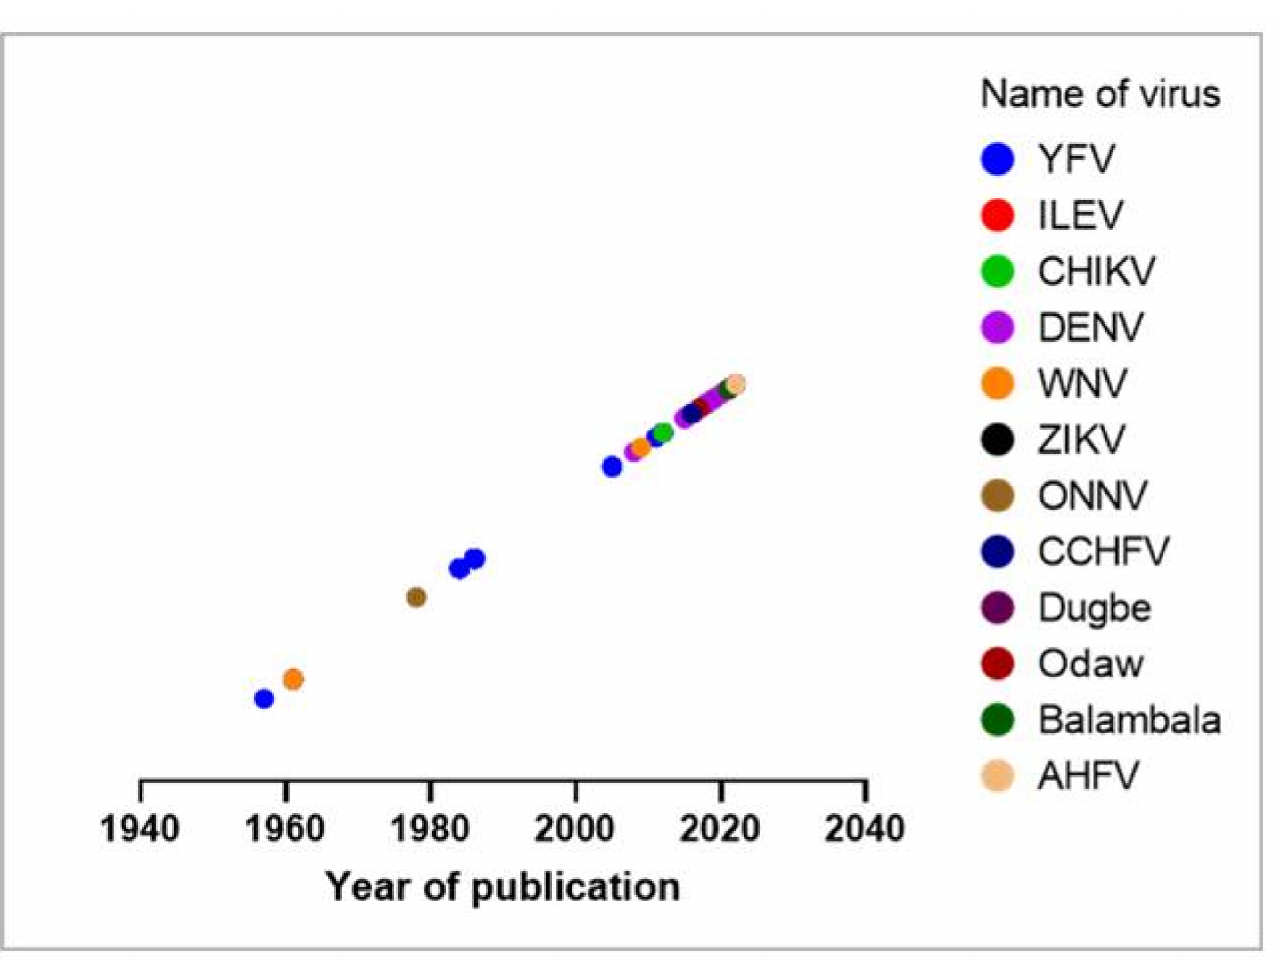
Figure 1. Bubble plot of arboviruses investigated in Ghana (1955–2022). YFV = Yellow fever virus; ILEV = IIesha virus; CHIKV = Chikungunya virus; DENV = Dengue virus; WNV = West Nile virus; ZIKV = Zika virus; ONNV = Onyongnyong virus; CCHFV = Crimean–Congo hemorrhagic fever virus; AHFV = Alkhurma hemorrhagic fever